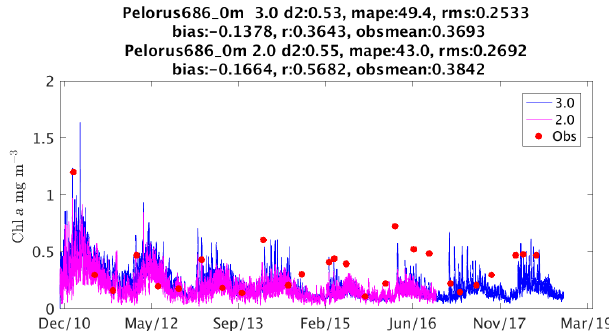
Figure 14. Observed surface chlorophyll concentration from chlorophyll extraction (red dots) at the Pelorus Island Marine Mon- itoring Program site (18 ◦ 33 (cid:48) S, 146 ◦ 29 (cid:48) E) with a comparison to configurations vB2p0 (pink line) and vB3p0 (blue line). Statistics listed include the Willmott d2 metric (Willmott et al., 1985), mean absolute percent error (MAPE) and